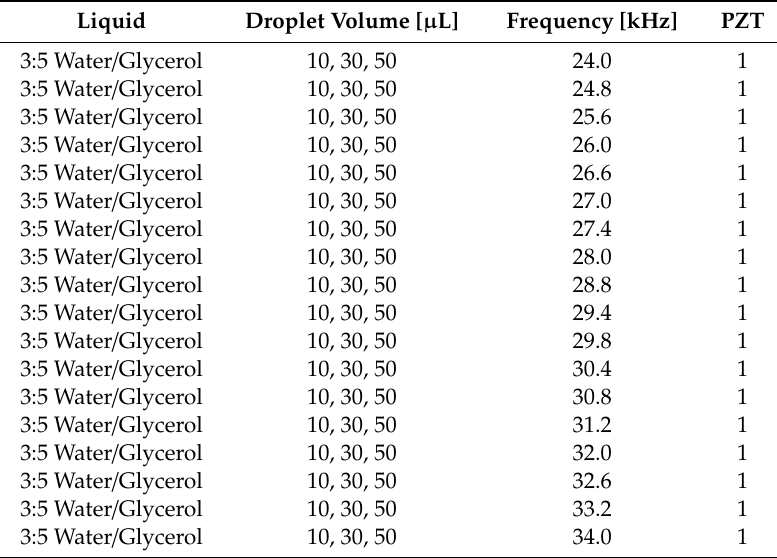
Table A2. Testing parameters used for the experiments conducted with water / glycerol to investigate material property e ff ects.